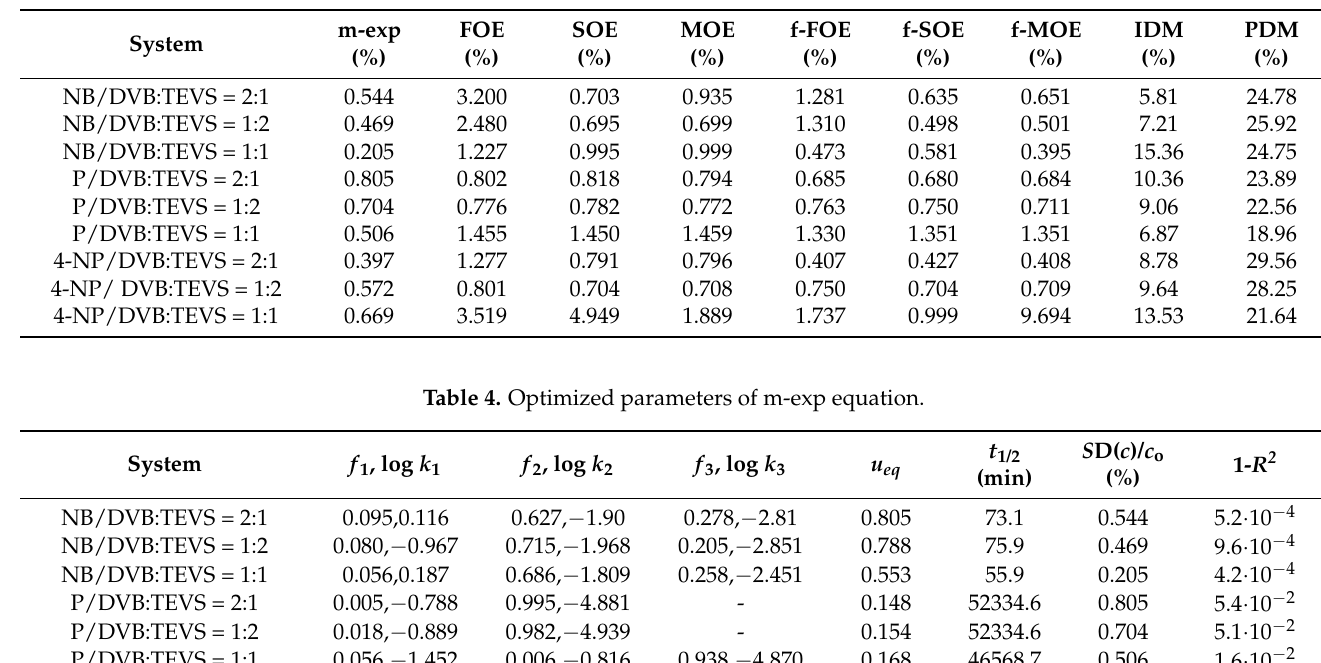
Table 3. Relative standard deviations SD(c)/co (%) for m-exp, FOE, SOE, MOE, f-FOE, f-SOE, F-MOE, McKay pore diffusion (PDM) and IDM model (Crank).